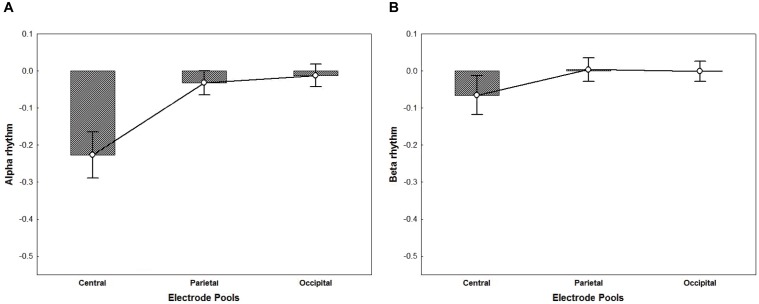
The plots represent the main effect of Electrode Pools for alpha rhythm (p < 0.001) (A) and beta rhythm (p < 0.05) (B) irrespective of groups. Negative values indicate suppression whereas a value of zero indicates no suppression and values greater than zero indicate enhancement. The ANOVA performed on alpha (A) and beta (B) activity showed that mu rhythm was significantly more suppressed in the Central Electrode Pool vs. the Parietal and the Occipital ones. Error bars represent standard error of mean (SE).